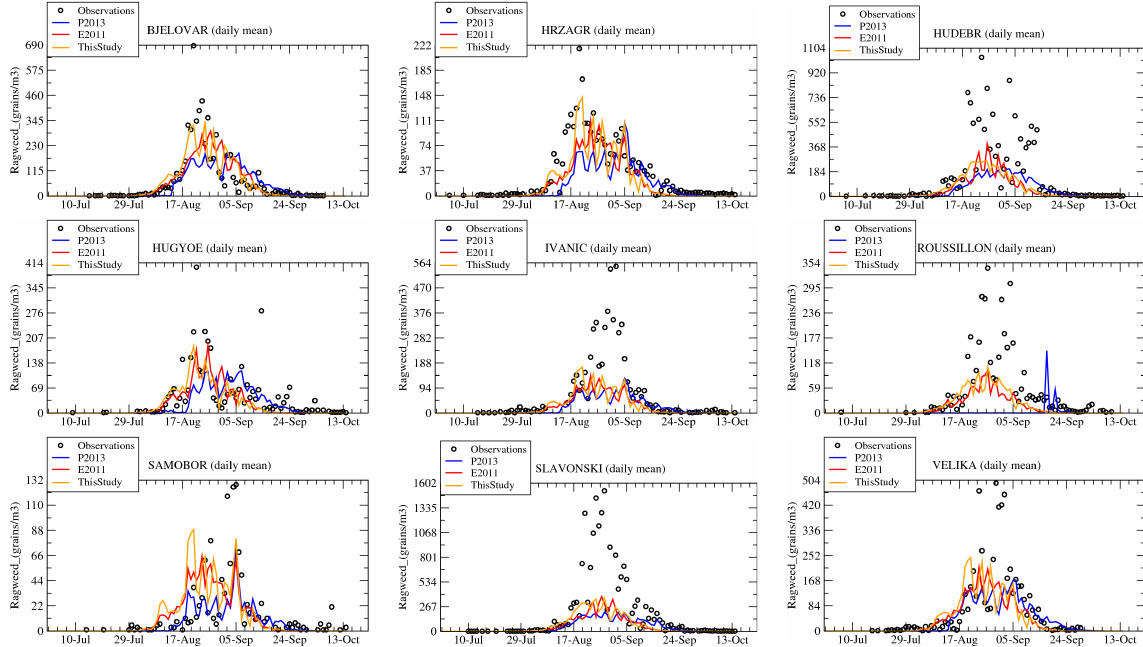
Figure 3. Time series of observed and modelled ragweed pollen surface concentrations for several stations and the year